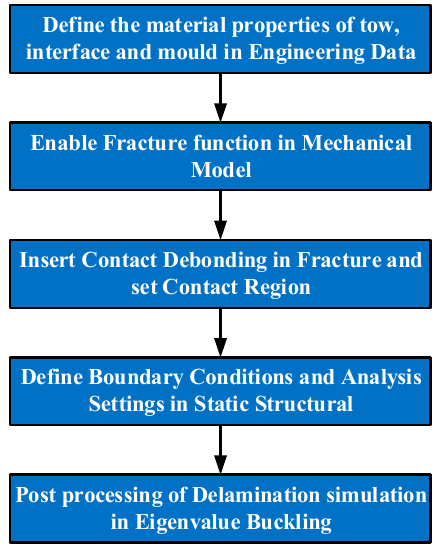
Figure 8. Flow chart of delamination simulation.